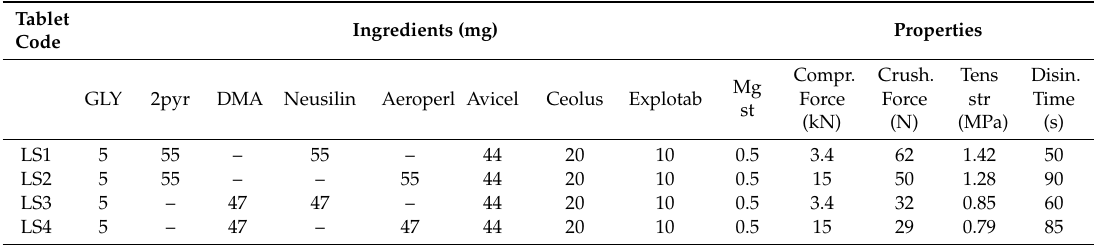
Table 2. Composition and properties of glyburide (GLY) liquisolid tablets.